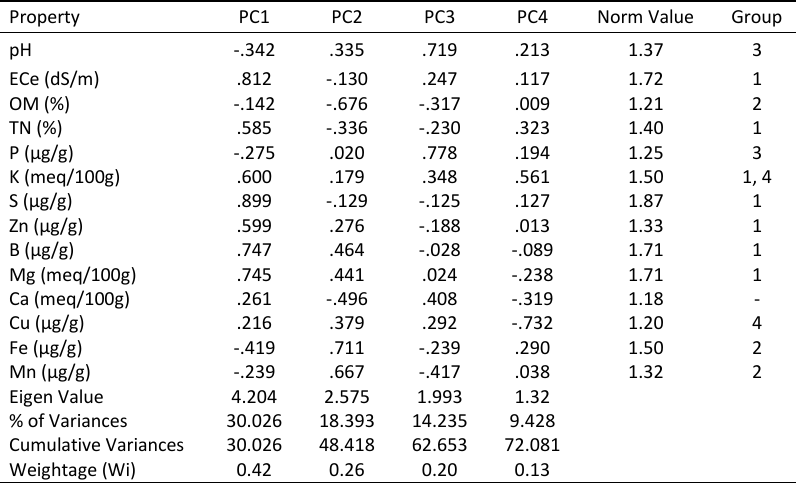
Table 3: Results of PCA of 14 soil properties and their norm values and